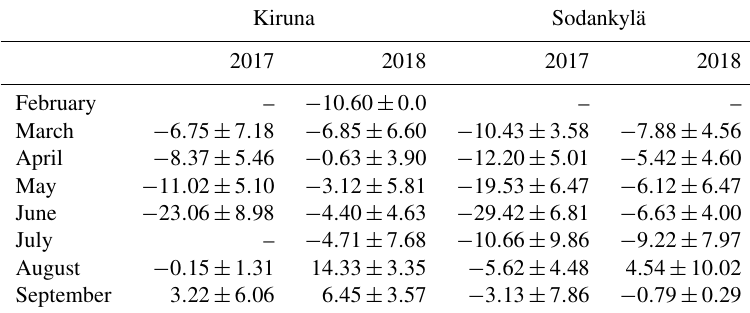
Table 2. Monthly averaged difference and standard deviation of XCH 4 (in ppb) between CAMS and COCCON-CAMS at two sites in 2017 and